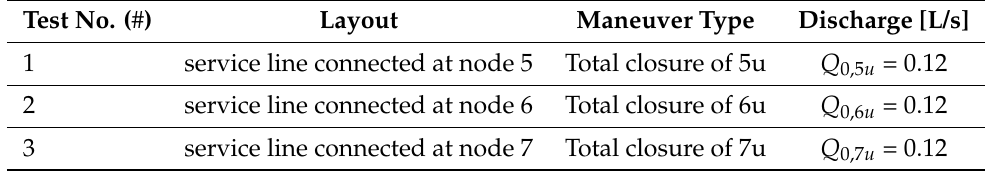
Table 1. Main characteristics of the executed laboratory